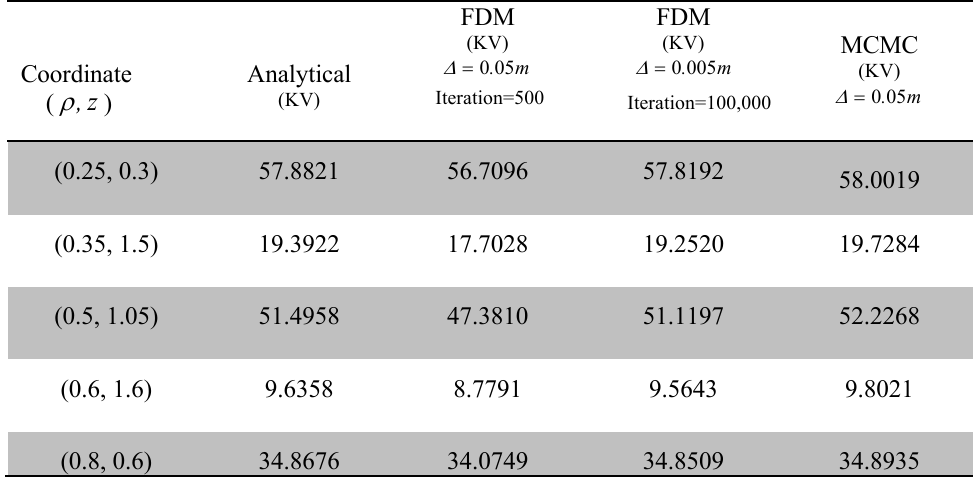
Table 4. Comparison for Analytical, FDM and MCMC for Axisymmetric Inhomogeneous